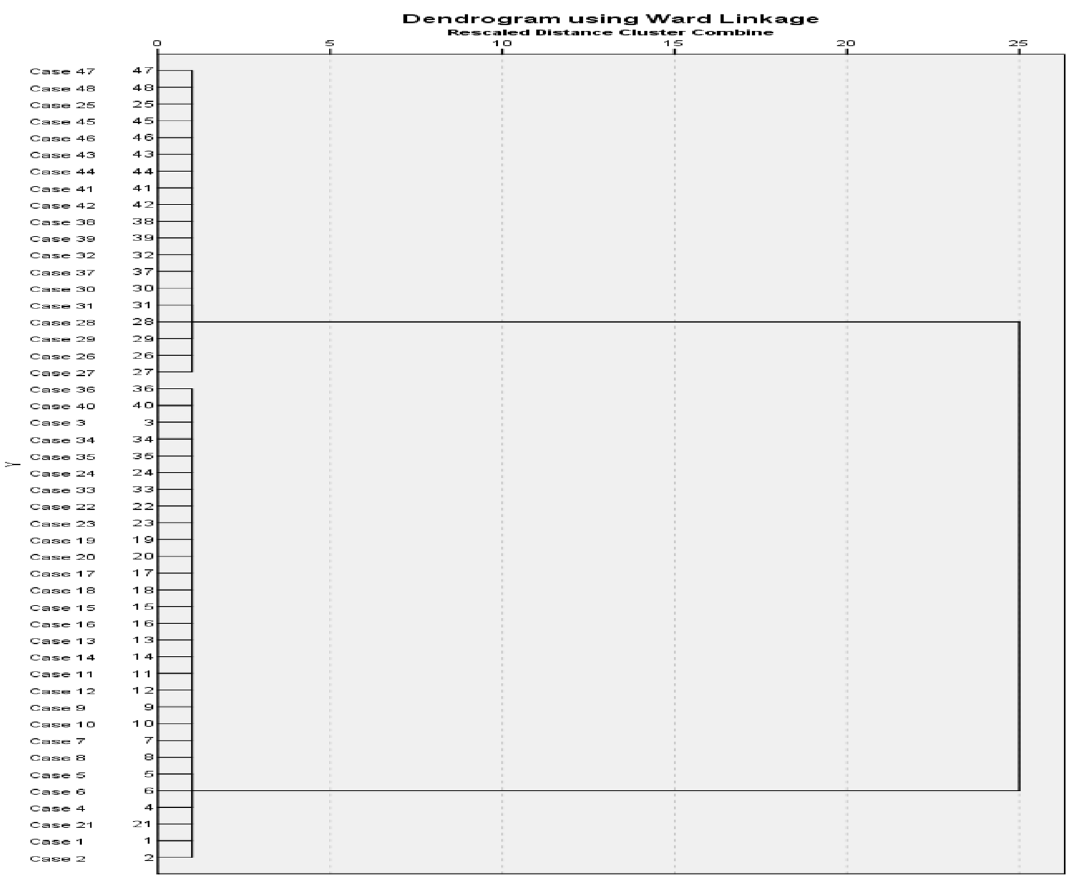
Fig. 2 Dendrogram showing of the physicochemical parameters measured in the water sources using Ward